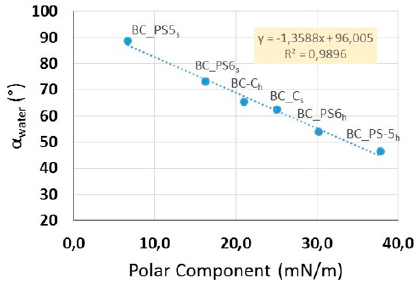
Figure 2. Relation between the polar component of surface free energy of the samples and their static contact angles obtained with water.